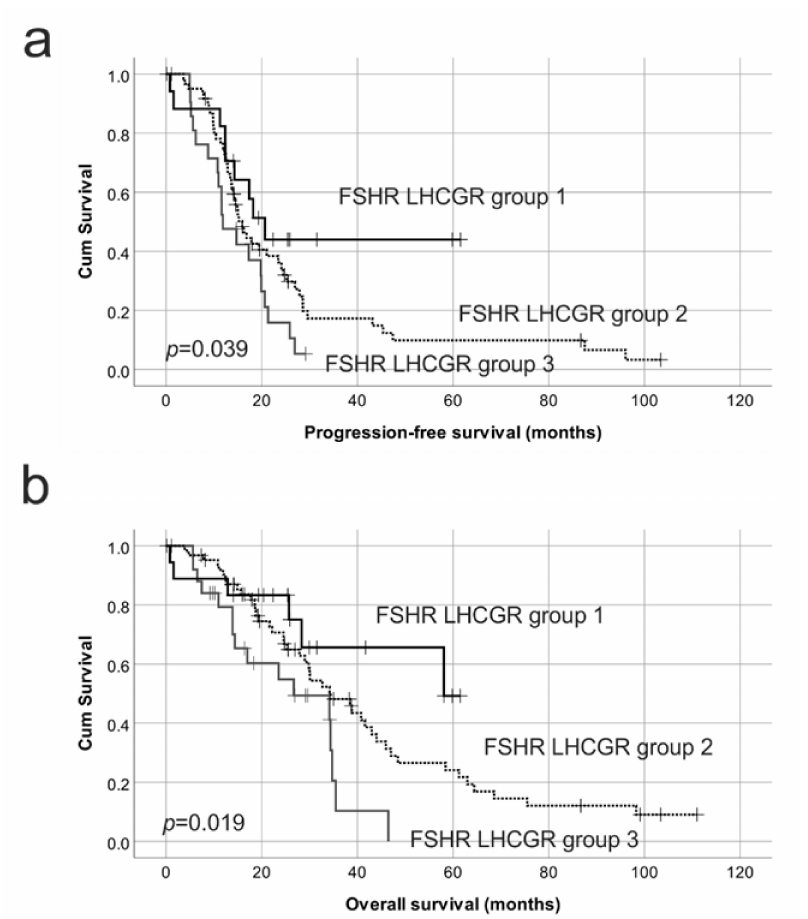
Figure 8. Kaplan–Meier survival analysis showing the relationship with combined FSHR and LHCGR protein expression with progression-free survival (PFS) and overall survival (OS). ( a ) Combined FSHR and LHCGR immunoreactive score groups with PFS. Group 1 = FSHR IR ≥ 3 and LHCGR IR ≥ 3 (relapse; 9/18 patients); Group 2 = FSHR IR ≥ 3 and LHCGR ≤ 2 or FSHR IR ≤ 2 and LHCGR IR ≥ 3 (relapse; 49/61 patients); Group 3 = FSHR IR ≤ 2 and LHCGR IR ≤ 2 (relapse; 19/21 patients) ( b ) Combined FSHR and LHCGR immunoreactive score groups with OS. Group 1 = FSHR IR ≥ 3 and LHCGR IR ≥ 3 (ovarian cancer death; 6/19); Group 2 = FSHR IR ≥ 3 and LHCGR ≤ 2 or FSHR IR ≤ 2 and LHCGR IR ≥ 3 (ovarian cancer death; 44/64); Group 3 = FSHR IR ≤ 2 and LHCGR IR ≤ 2 (ovarian cancer death;